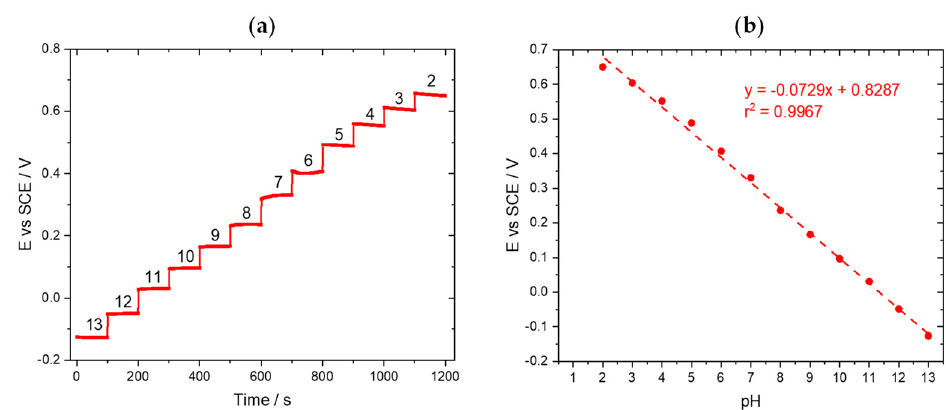
Figure 2. Cyclic voltammograms of IrOx growth with a scan rate of 50 mV/s.